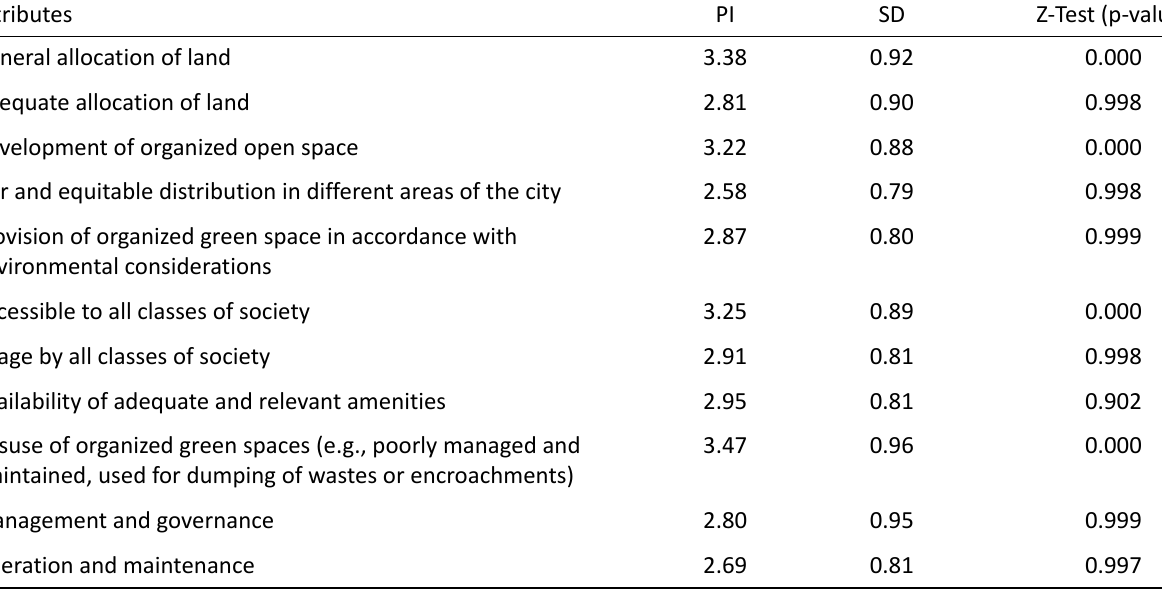
Table 2. Respondents’ perceptions of the provision, development, and management of organized green space.